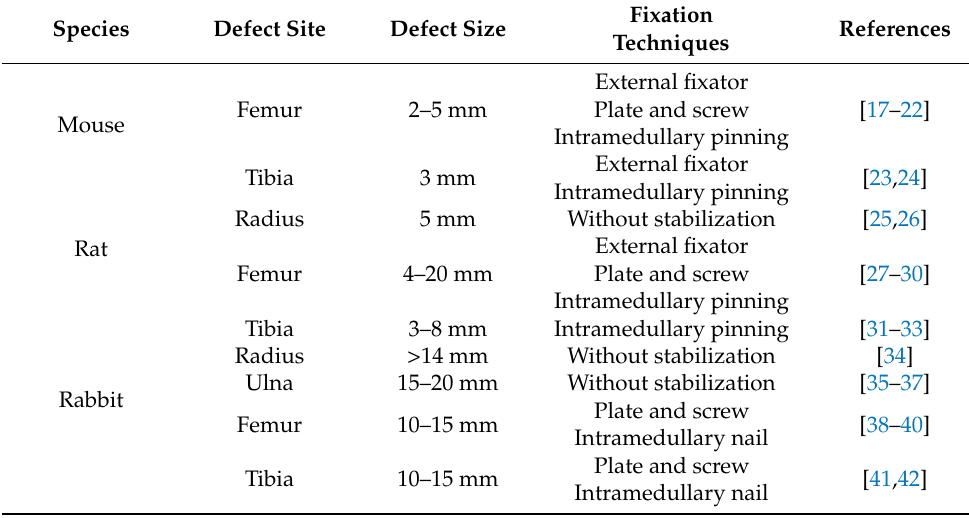
Table 1. Animal models of the segmental critical-size bone